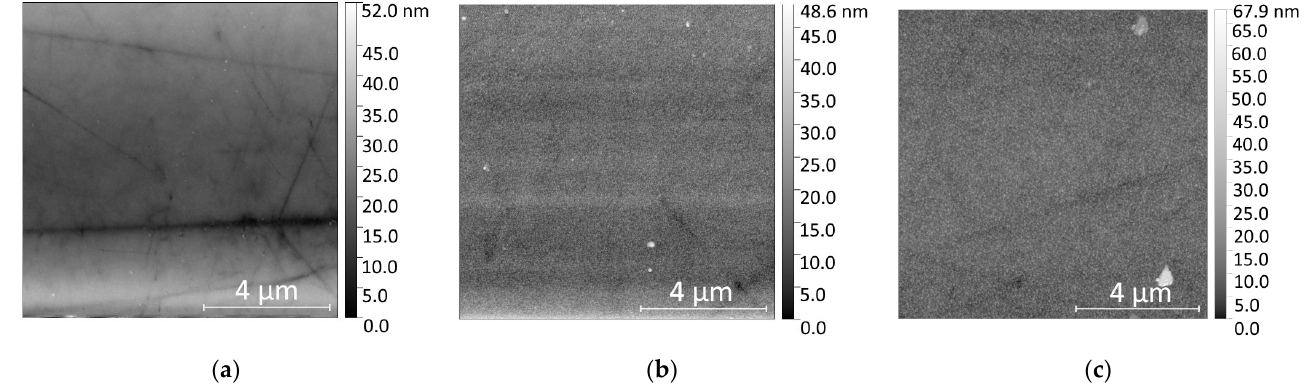
Figure 10. Surface topography of the deposited layer when using a DC power supply for the depo- sition times of ( a ) 5 min, ( b ) 10 min and ( c ) 15 min.